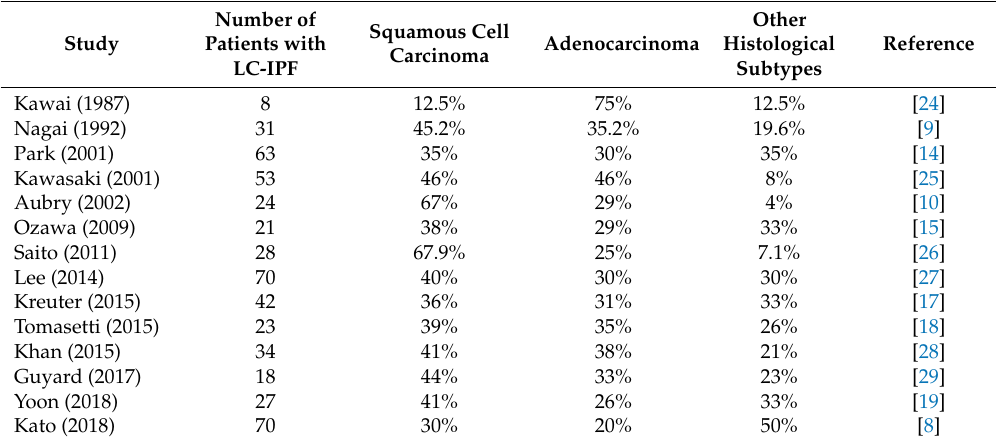
Table 2. Lung cancer (LC) histological subtypes in patients with idiopathic pulmonary fibrosis